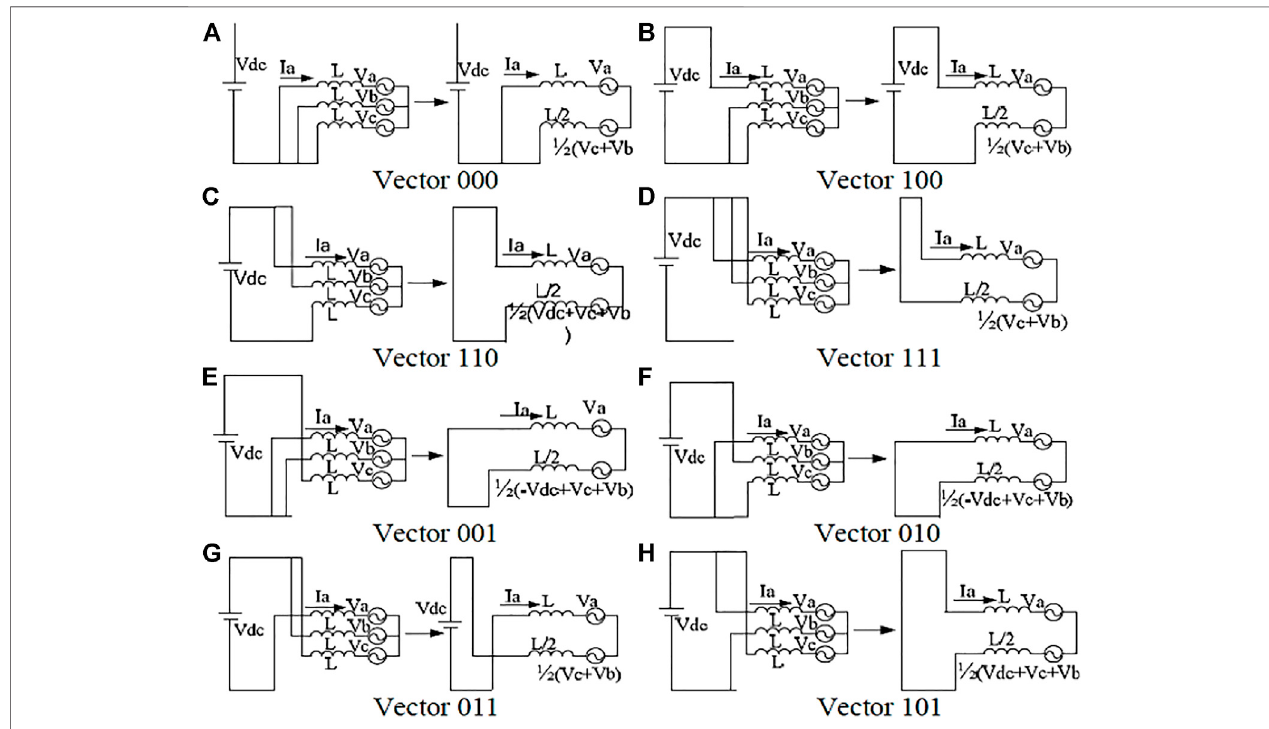
FIGURE 4 | Corresponding circuits for all